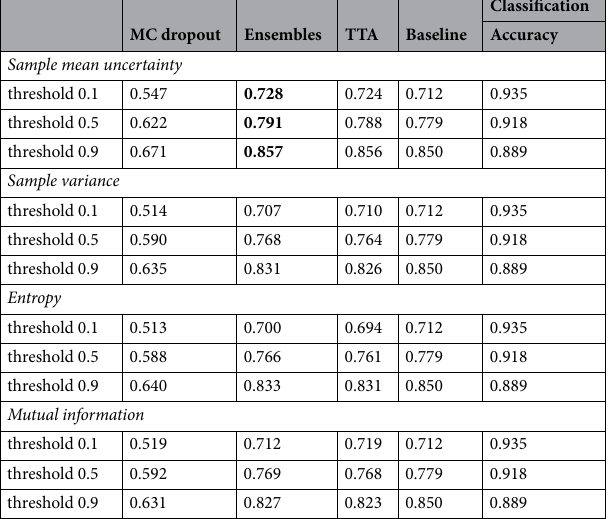
MC dropout Ensembles TTA